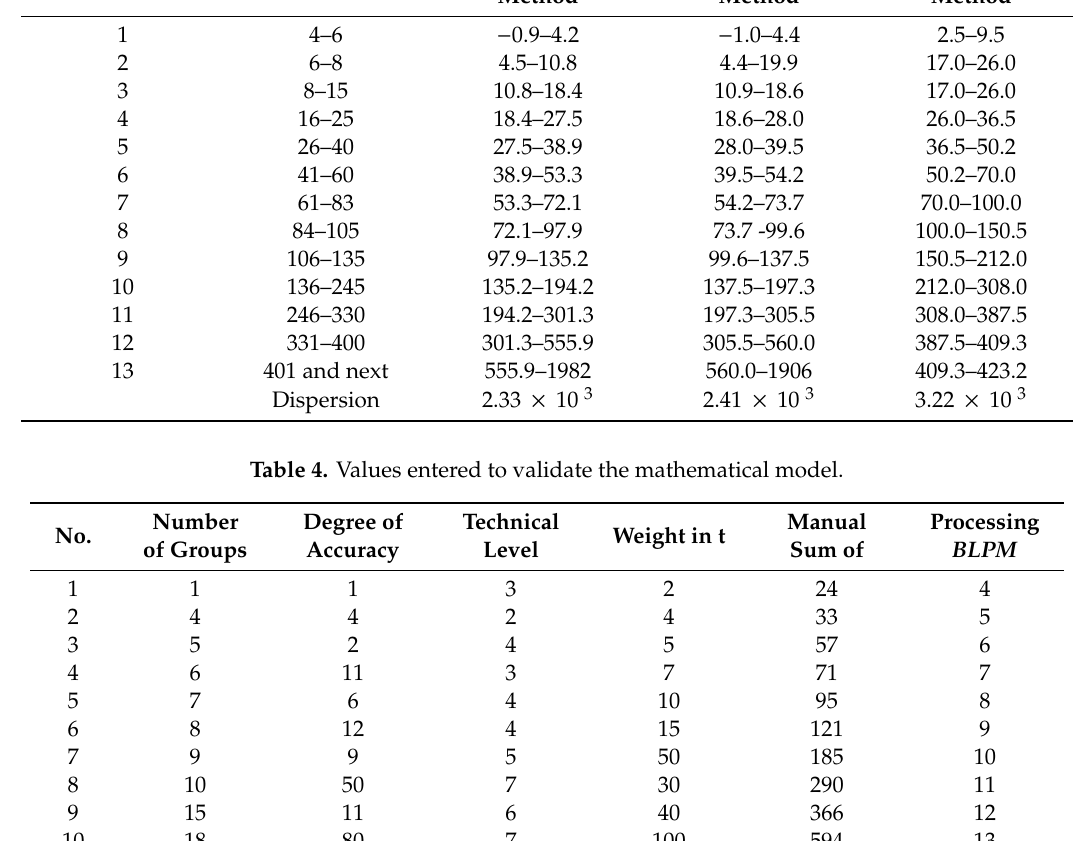
Table 3. Evaluation of approximation of basic level of maintenance labor intensity. Basic Level of